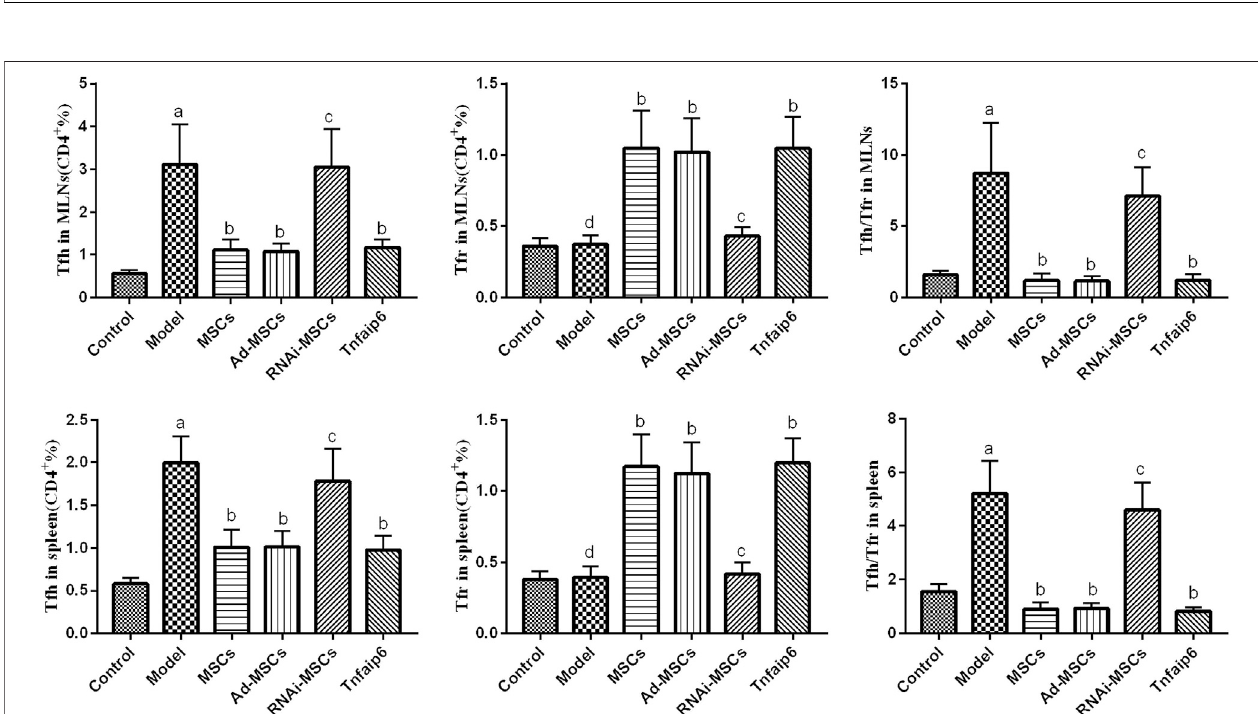
FIGURE 11 | Comparisons of Tfh, Tfr, and Tfh/Tfr in CD4 + cells in the MLNs and spleen in mice detected by fl ow cytometry. a p < 0.05 compared to the control group. b p < 0.05 compared to the model group. c p > 0.05 compared to the model group. d p > 0.05 compared to the control group. n ≥ 9 per group.